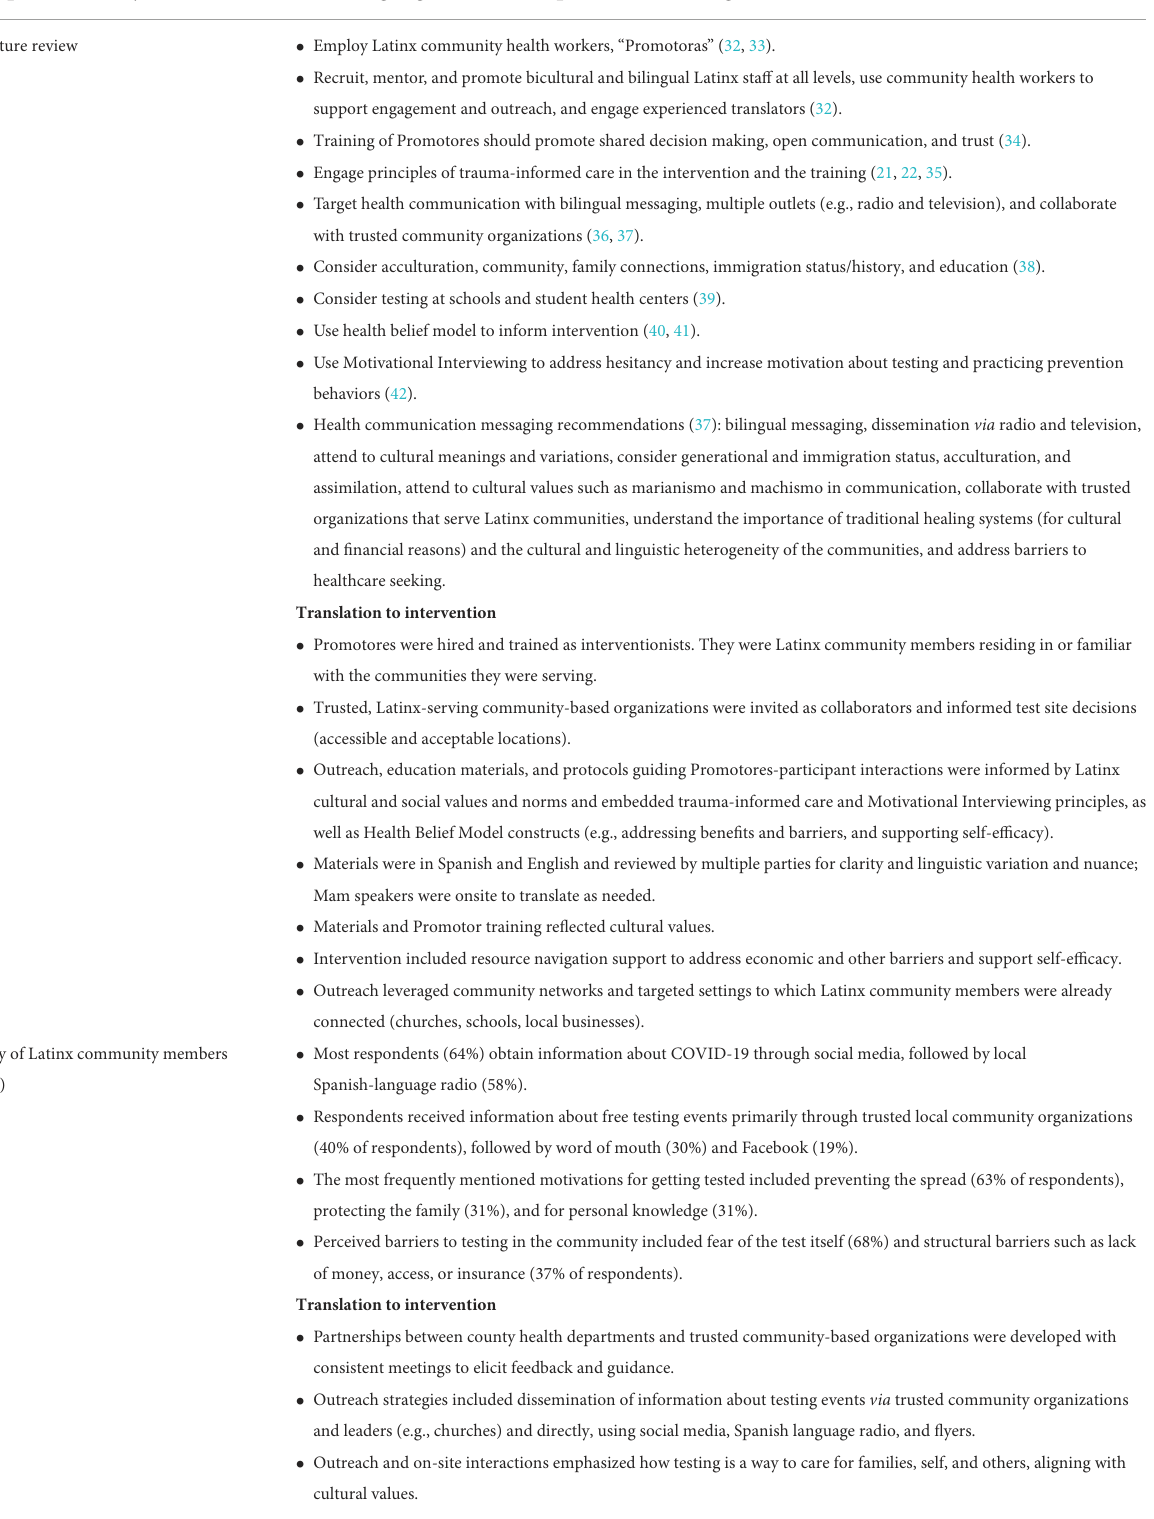
TABLE 2 Summary of results from intervention development activities. Development